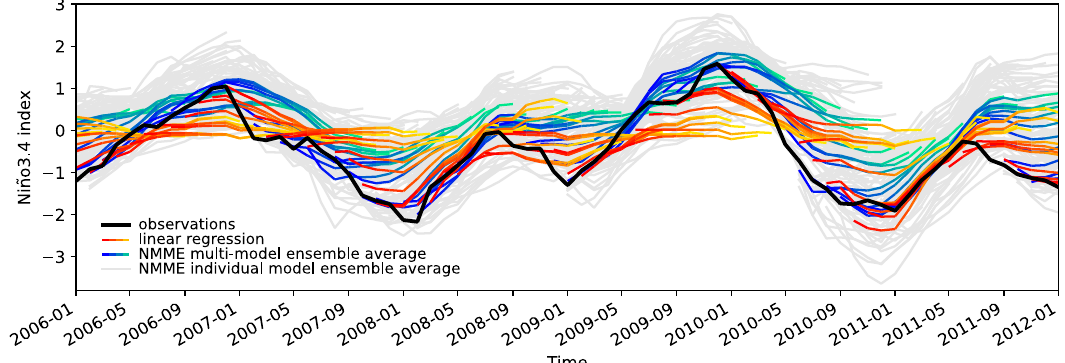
Fig. 1 El Niño Southern Oscillation (ENSO) time series and forecasts. The black line shows the observed value of Niño3.4. The blue/green lines are 12- month forecasts of Niño3.4 for the North American Multimodel Ensemble (NMME) and Copernicus Climate Change Service (C3S) multimodel ensemble mean. The shading for these forecast lines runs from dark blue for the fi rst month of the forecast through green for long lead times. The red/yellow lines are 12-month forecasts of Niño3.4 for the linear regression model, where the fi rst month is shaded red and longer leads are yellow. The grey lines are ensemble mean forecasts from individual NMME and C3S models. The fair method is used to